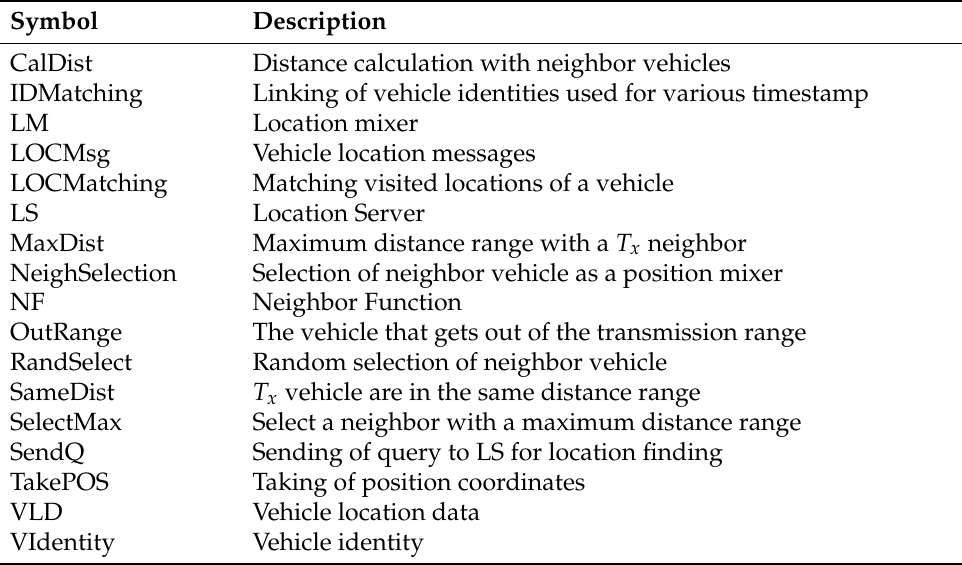
Table 6. Symbols used in HLPN for position-mixing